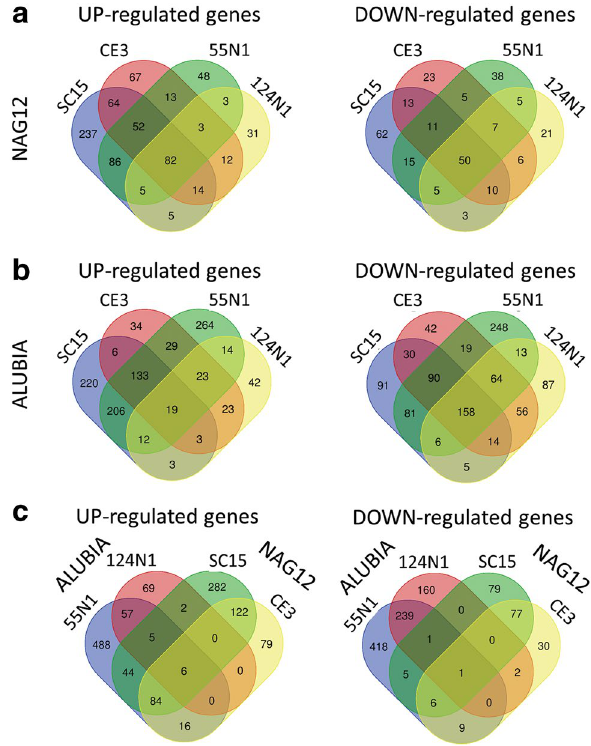
Figure 3. Identification of common and strain-specific differentially expressed genes. Venn diagrams showing the number and overlap of up- and down-regulated DEGs in NAG12 ( a ) and Alubia ( b ) in response to the strains of R. etli SC15 and CE3 ( nod C-α), 55N1 and 124N1 ( nod C-δ) or in the highly efficient interactions of each common bean accession with their cognate strains ( c